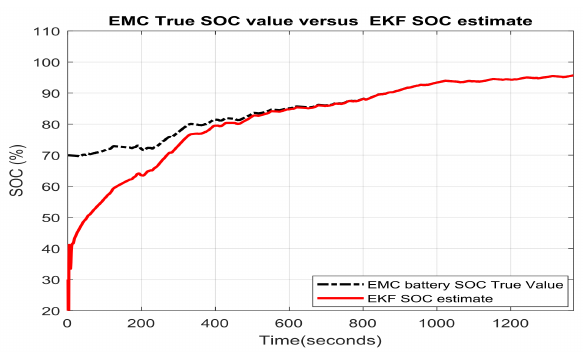
Figure 19. Robustness of EKF estimator to a decrease in SOC initial value.